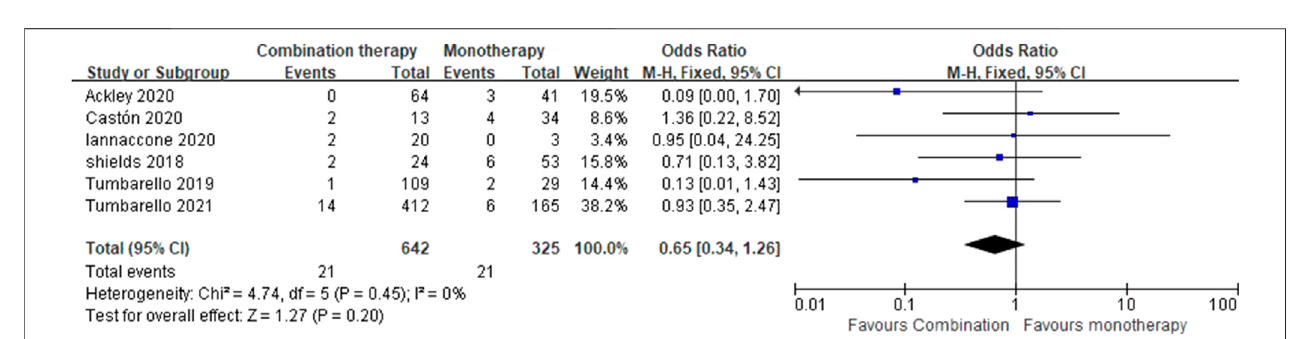
Frontiers in Pharmacology |